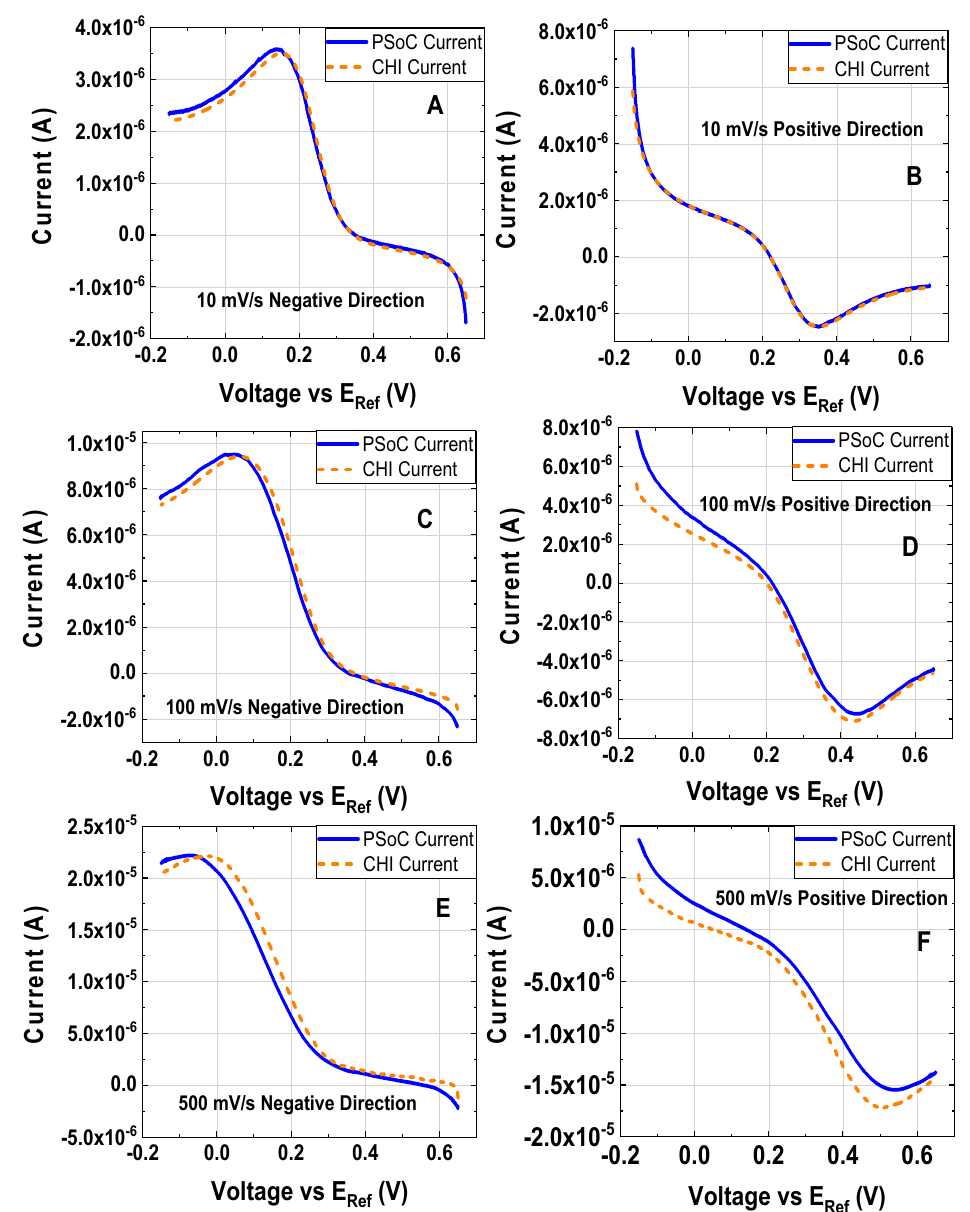
Figure 8. Linear sweep voltammetry at different scan rates at different first step potentials of 1 mM K 3 [Fe(CN) 6 ] and 0.5 M KCl as the electrolyte support; the working electrode, the counter electrode and the reference electrode were a disk glassy carbon electrode (diameter φ = 3 mm), a platinum wire and Ag/AgCl electrode, respectively. All voltages are reported vs. Ag/AgCl. ( A ) Scan rate 10 mV/s, initial and final voltage are 0.65 V and − 0.15 V, respectively (experiment under the conditions 10). ( B ) Scan rate 10 mV/s, initial and final voltage are − 0.15 V and 0.65 V, respectively (experiment under the conditions 11). ( C ) Scan rate 100 mV/s, initial and final voltage are 0.65 V and − 0.15 V, respectively (experiment under the condition 12). ( D ) Scan rate 100 mV/s, initial and final voltage are − 0.15 V and 0.65 V, respectively (experiment under the conditions 13). ( E ) Scan rate 500 mV/s, initial and final voltage are 0.65 V and − 0.15 V, respectively (experiment under the conditions 14). (F) Scan rate 500 mV/s, initial and final voltage are − 0.15 V and 0.65 V, respectively (experiment under the conditions